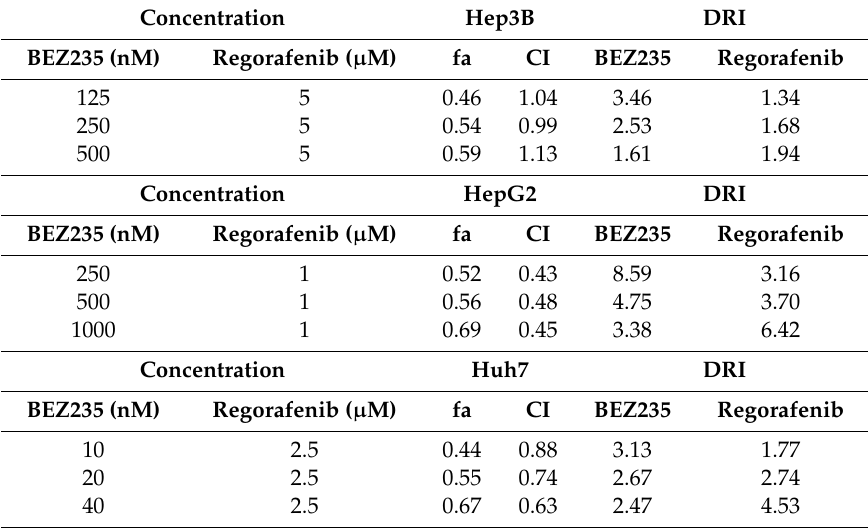
Figure 1. BEZ235 enhances the anti-proliferation effect of regorafenib in HCC cells. The cell viability analysis for HCC cells treated for 48 h with ( A ) BEZ235 or ( B ) regorafenib. ( C ) Cell viability analysis for the HCC cells treated with various combinations of BEZ235 and regorafenib for 48 h. Scale bar: 50 μm. Data are represented as mean ± S.D. * p < 0.05, and ** p < 0.01 versus untreated control, and BEZ235 or regorafenib alone group. Table 1. CI and DRI of BEZ235 and Regorafenib combination in HCC.